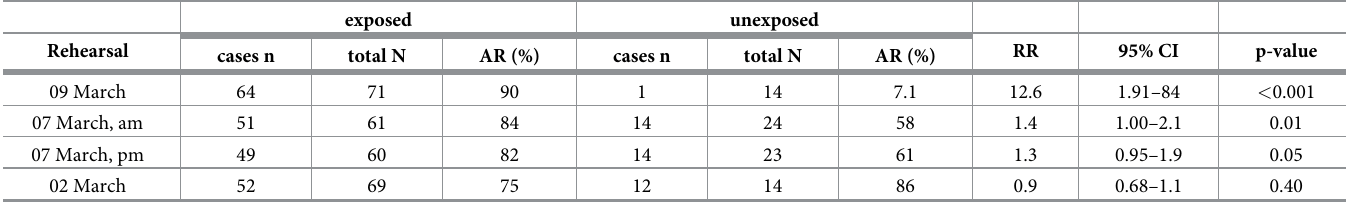
Table 1. Risk ratios of laboratory confirmed SARS-CoV-2 infection for participation in different rehearsals of choir 1, Berlin, March 2020. exposed